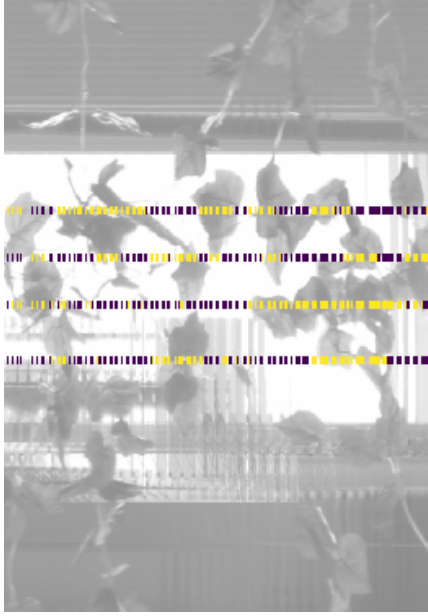
Figure 4. Collected data superimposed on a detail of the panoramic image of the synthetic vineyard: yellow points correspond to reflected IR rays, violet points to non-returning